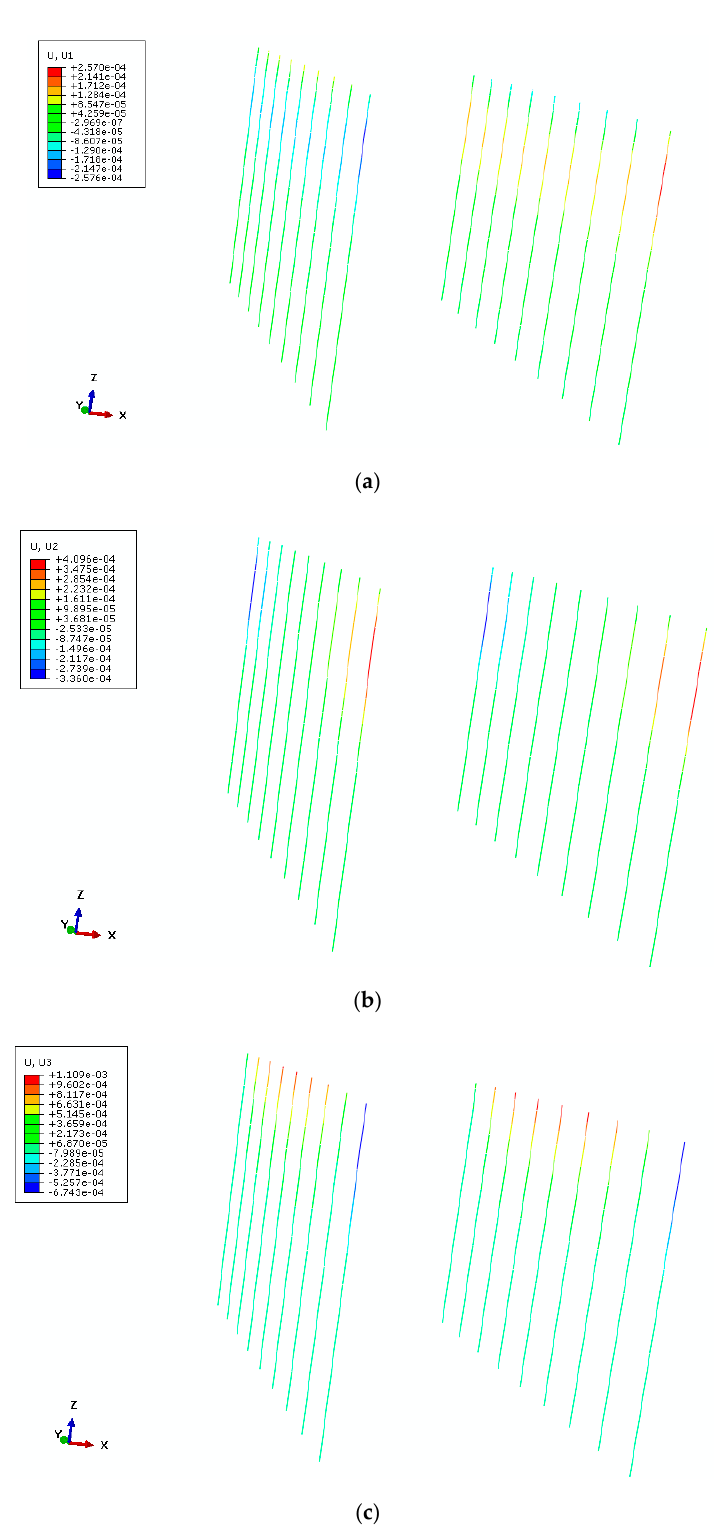
Figure 13. Deformation cloud of the right retaining pile. ( a ) x direction; ( b ) y direction; ( c ) z direction.